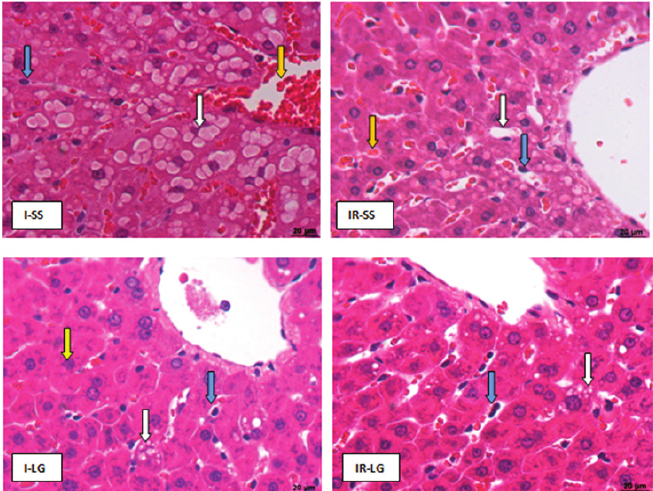
FIGURE 2 - Histological damage in the I-SS and IR-SS groups (top). Extensive area of hepatic necrosis, severe disarrangement of the hepatic columnar cells, cytoplasmic vacuoles (white arrows), PMNL infiltration (blue arrows), vascular congestion (orange arrows) and nuclear pyknosis (yellow arrows). Histological damage in the I-LG and IR-LG groups (bottom). Rare hepatic necrosis, preservation of the hepatic columnar cells, rare cytoplasmatic vaculoes (white arrows), minimal PMNL inflitration (blue arrows), an absence of vascular congestion and puctuate nuclerar pyknosis (yellow arrows). Hematoxylin and eosin (magnification